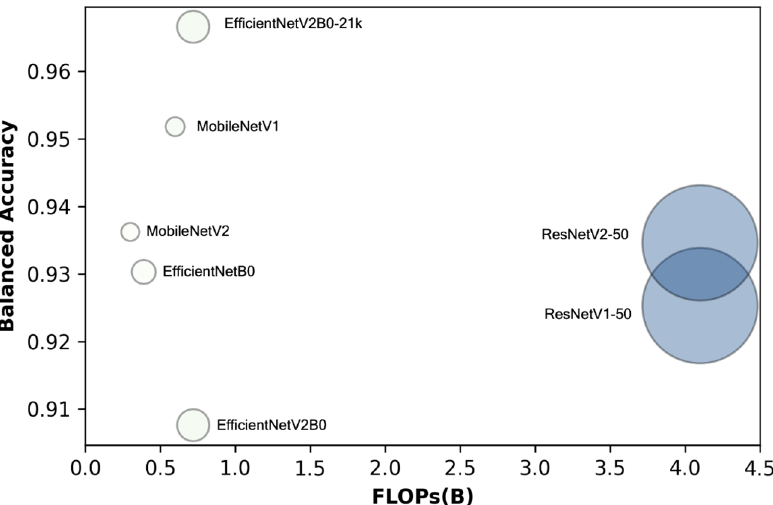
Figure 6. The floating-point operations per second (FLOPs) and parameters versus the balanced accuracy of the seven CNN models on FBCG dataset from the fivefold stratified CV (FLOPs in the x-axis depicts the number of operations in billions, while the radius of the circle represents the number of parameters in millions). The EfficientNetV2-B0-21k model scored the highest score (0.9666) with relatively low FLOPs (0.72B) and parameters (7.1 M). The ResNetV1-50 model achieved a low accuracy (0.9253) score with the highest FLOPs (4.1B) and parameters (25.6 M). Most of the CNN models scored average accuracy scores between 0.93 and 0.4. Generally, the average accuracy score is increasing with the FLOPs except for the EfficientNetV2B0 and ResNetV-501 and ResNetV2-50. There is no evidence that larger parameter CNN models (ResNetV1-50 and ResNetV2-50) are more accurate.